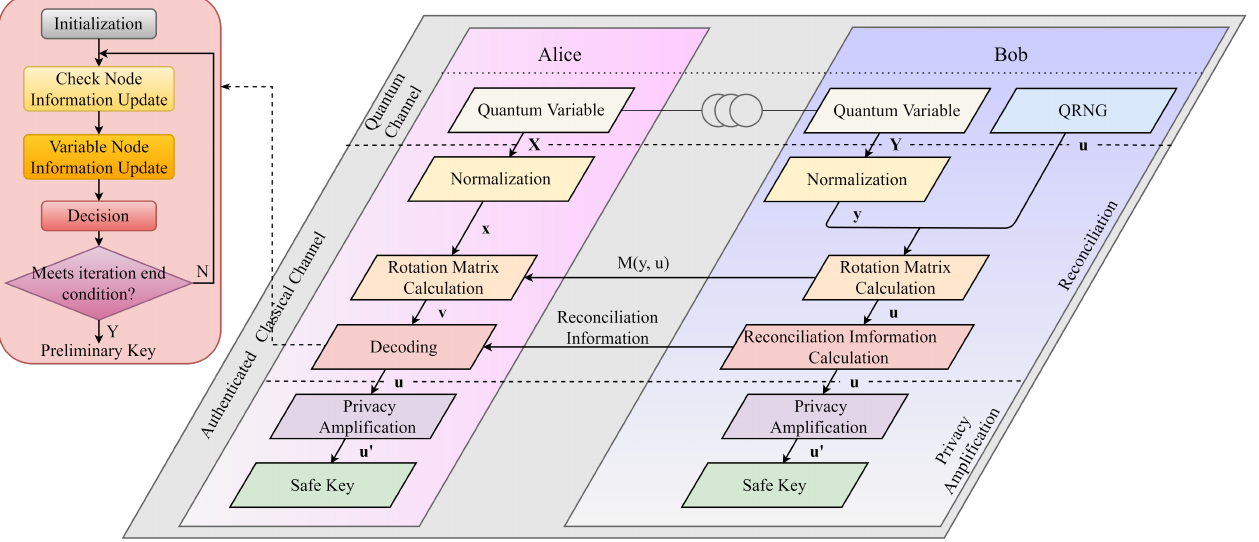
Figure 1. Flow chart of post-processing of reverse multi-dimensional reconciliation. Since decoding is the crucial step in reconciliation, we can improve the reconciliation performance by improving the decoding